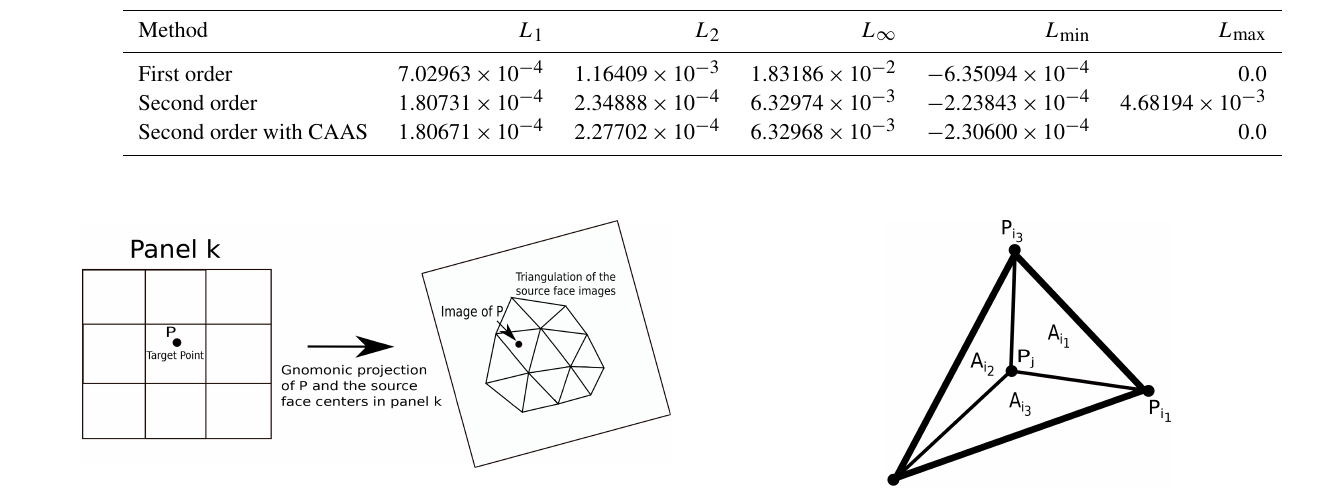
Figure 8. An overview of the Delaunay triangulation remapping scheme, whereby the images of the source face centers are triangu- lated.